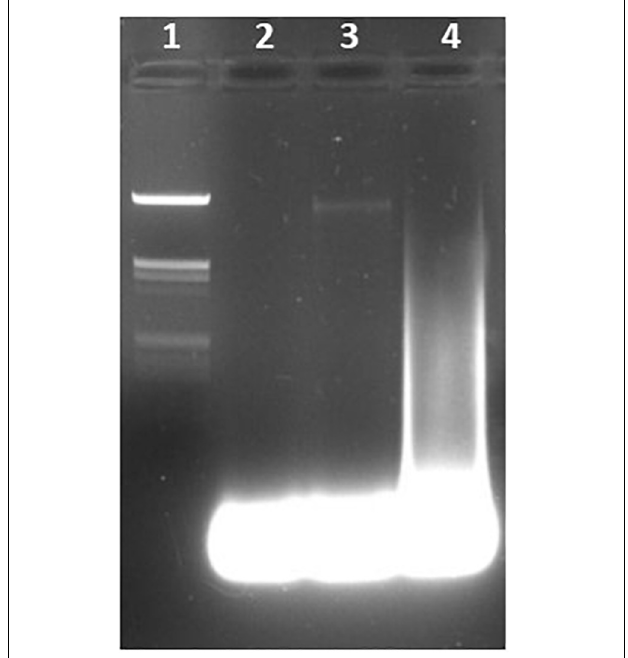
FIGURE 4 | Detection of the 23S rRNA gene of Enterococcus faecalis using LAMP. Lane 1, lambda Hin dIII marker. Lane 2, water (negative control). Lane 3, E. coli . Lane 4, E. faecalis DNA.